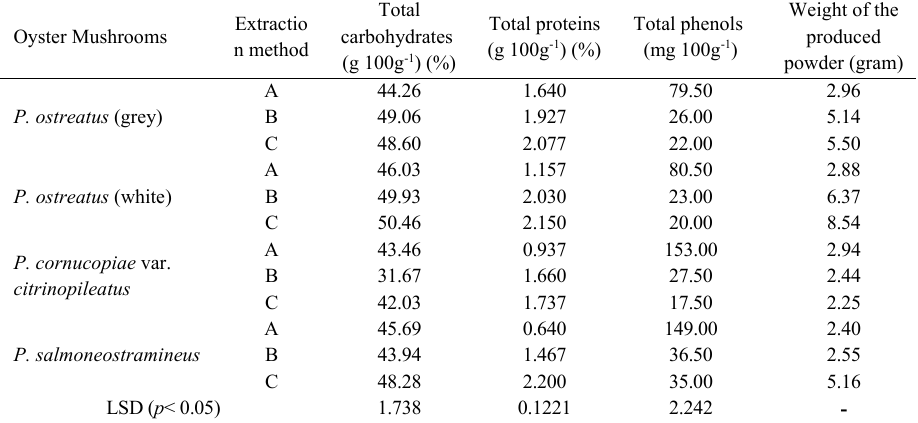
Table 1: Chemical composition of oyster mushrooms’ extract (for each 100 g dry matter) Total Extractio Oyster Mushrooms n method